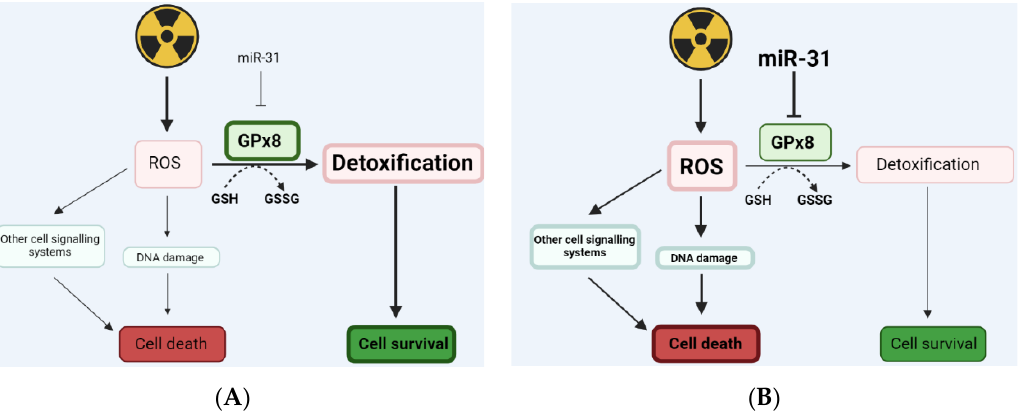
Figure 13. An illustration displaying how miR-31 may regulate levels of ROS by targeting GPx8. Radiation treatment can cause an increase in intracellular reactive oxygen species (ROS), which can target specific cell signalling systems and induce DNA damage directly, resulting in cell death. Glutathione peroxidase 8 (GPx8) is an enzymatic antioxidant that helps detoxify excessive ROS by converting reduced glutathione (GSH) into its oxidised form (GSSG), therefore promoting cell survival. ( A ) Low levels of miR-31 in PDAC cells may result in an increase in GPx8, supporting ROS detoxification and encouraging cell survival. ( B ) Whereas high levels of miR-31 in PDAC cells can potentially reduce GPx8. Moreover, reducing GPx8 can result in ROS accumulation, as ROS is being detoxified less efficiently, thus promoting cell death.